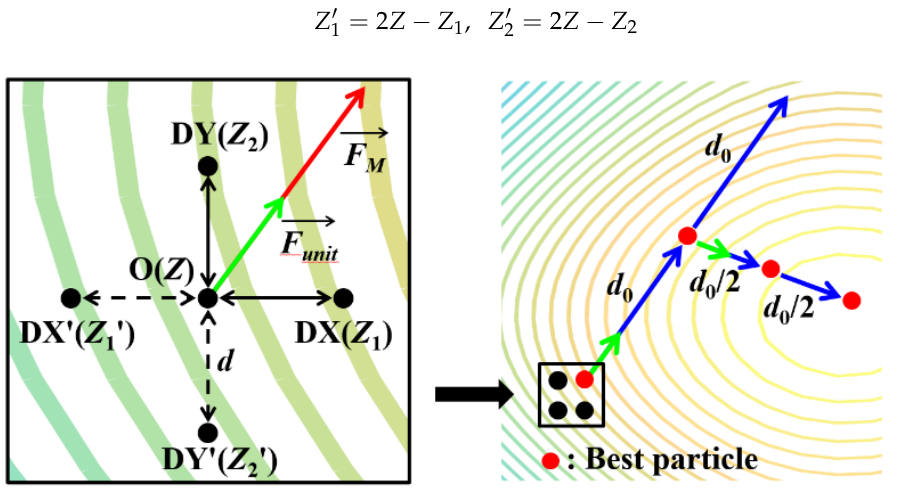
Figure 2. Conceptual schematic of VPSM.